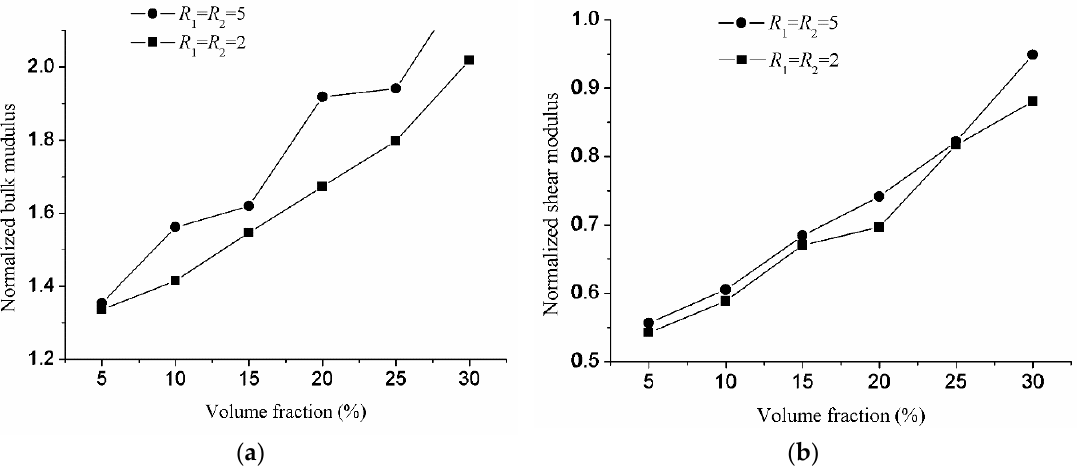
Figure 9. The variation of normalized modulus with the volume fraction for the aspect ratio being fixed: ( a ) bulk modulus; ( b ) shear modulus.